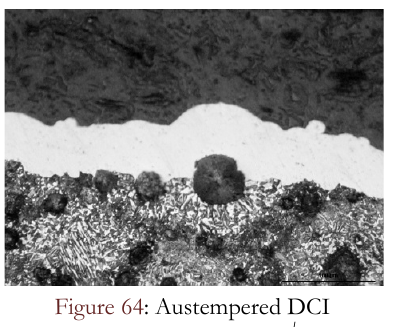
Figure 65: Austempered DCI (R = 0.1,  K = 9 MPa √ m).